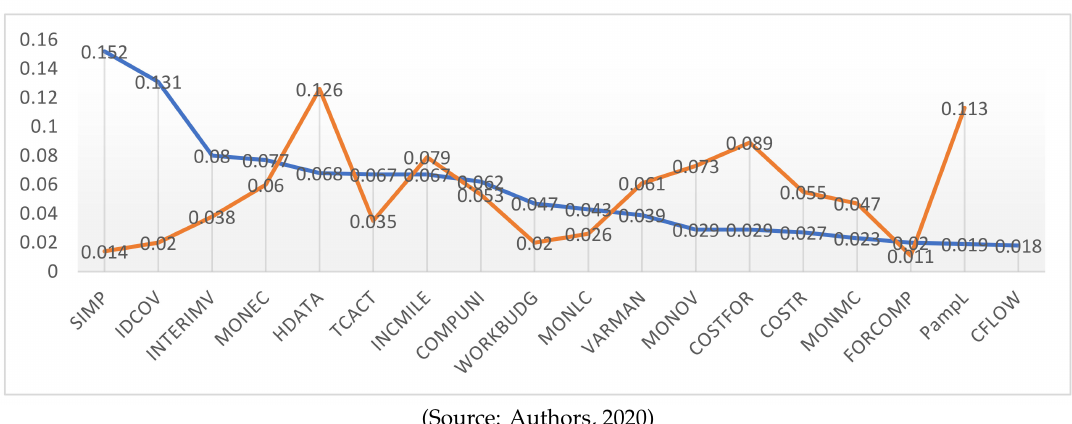
Figure 6. A comparison of the normalised importance for level 2 and validate independent